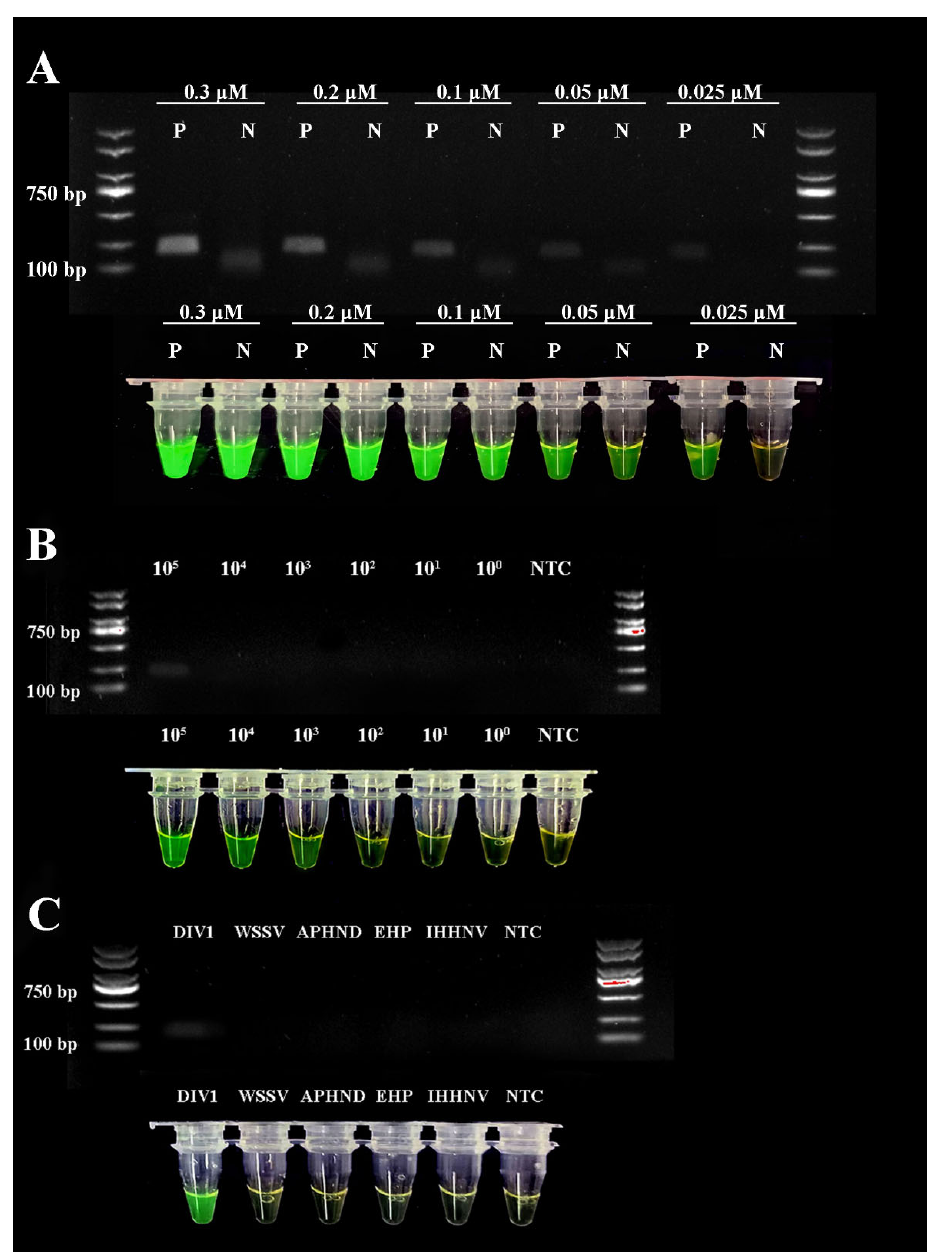
Figure 6. DIV1 ‐ RPA ‐ SYBR Green Ⅰ . ( A ) Optimization of the primer concentration. ( B ) The sensitivity Figure 6. DIV1-RPA-SYBR Green I. ( A ) Optimization of the primer concentration. ( B ) The sensitivity test of DIV1 ‐ RPA ‐ SYBR Green Ⅰ assay. ( C ) The specificity test of DIV1 ‐ RPA ‐ SYBR Green Ⅰ assay. test of DIV1-RPA-SYBR Green I assay. ( C ) The specificity test of DIV1-RPA-SYBR Green I